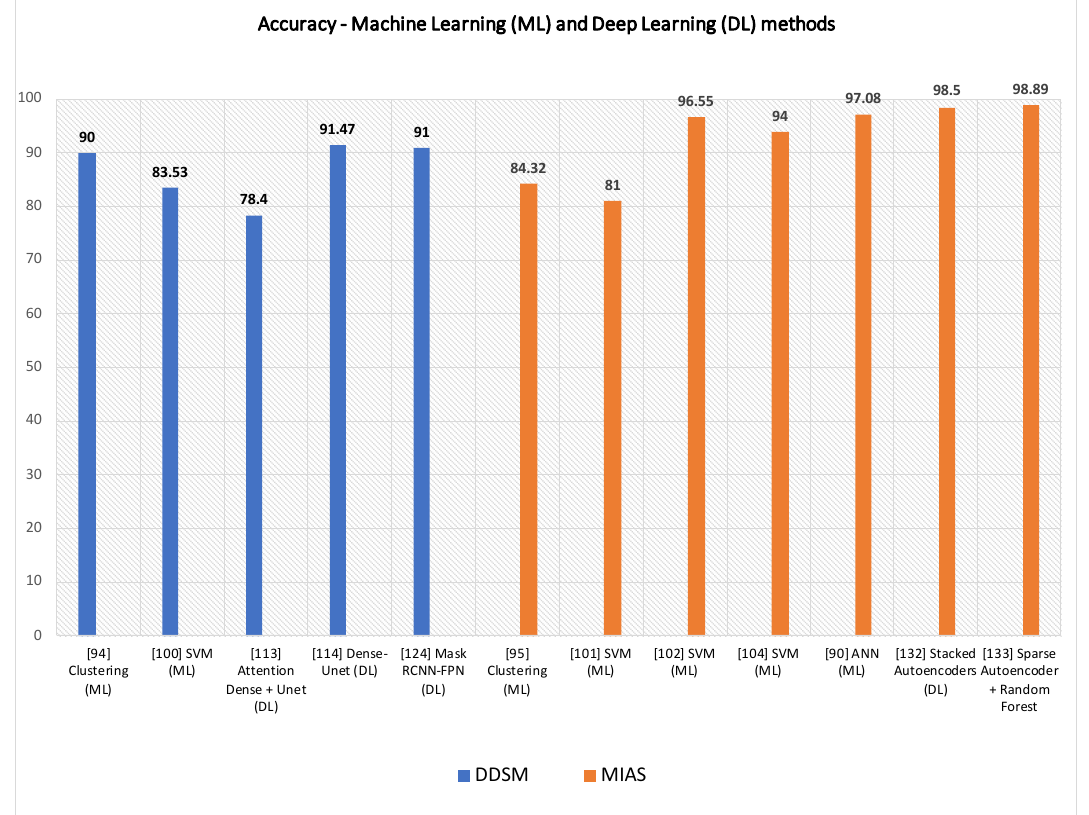
Figure 9. Some machine learning (ML) and deep learning (DL) techniques are shown above, according to their accuracy rates on DDSM and